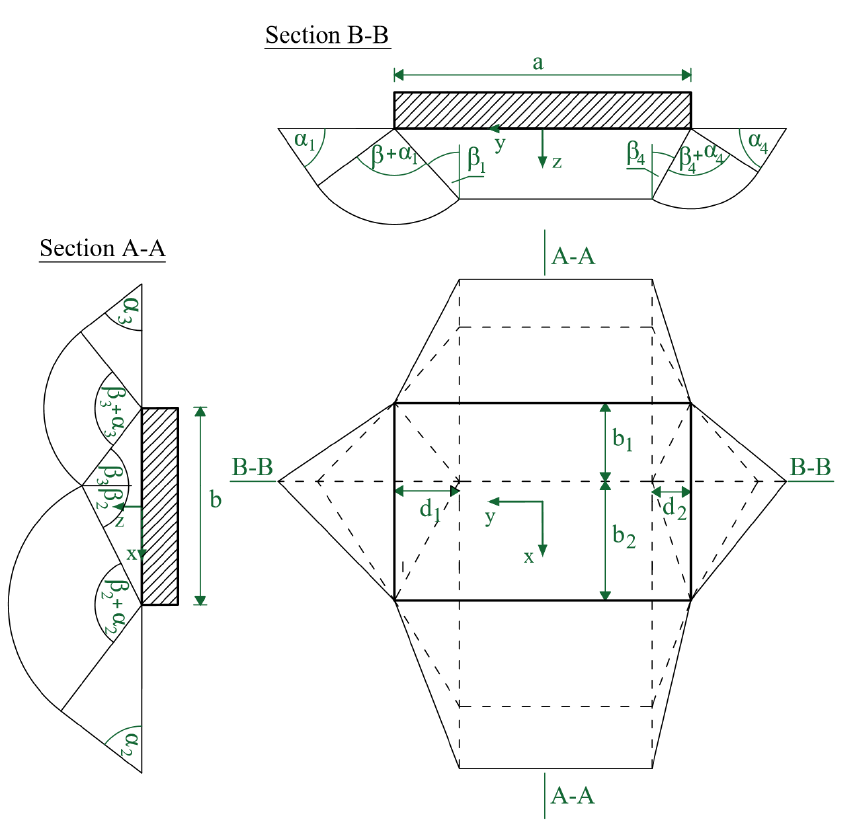
Figure 1: Failure geometry for a rough foundation base in the case of rectangular foundation. More details on failure geometry can be found in Chwała